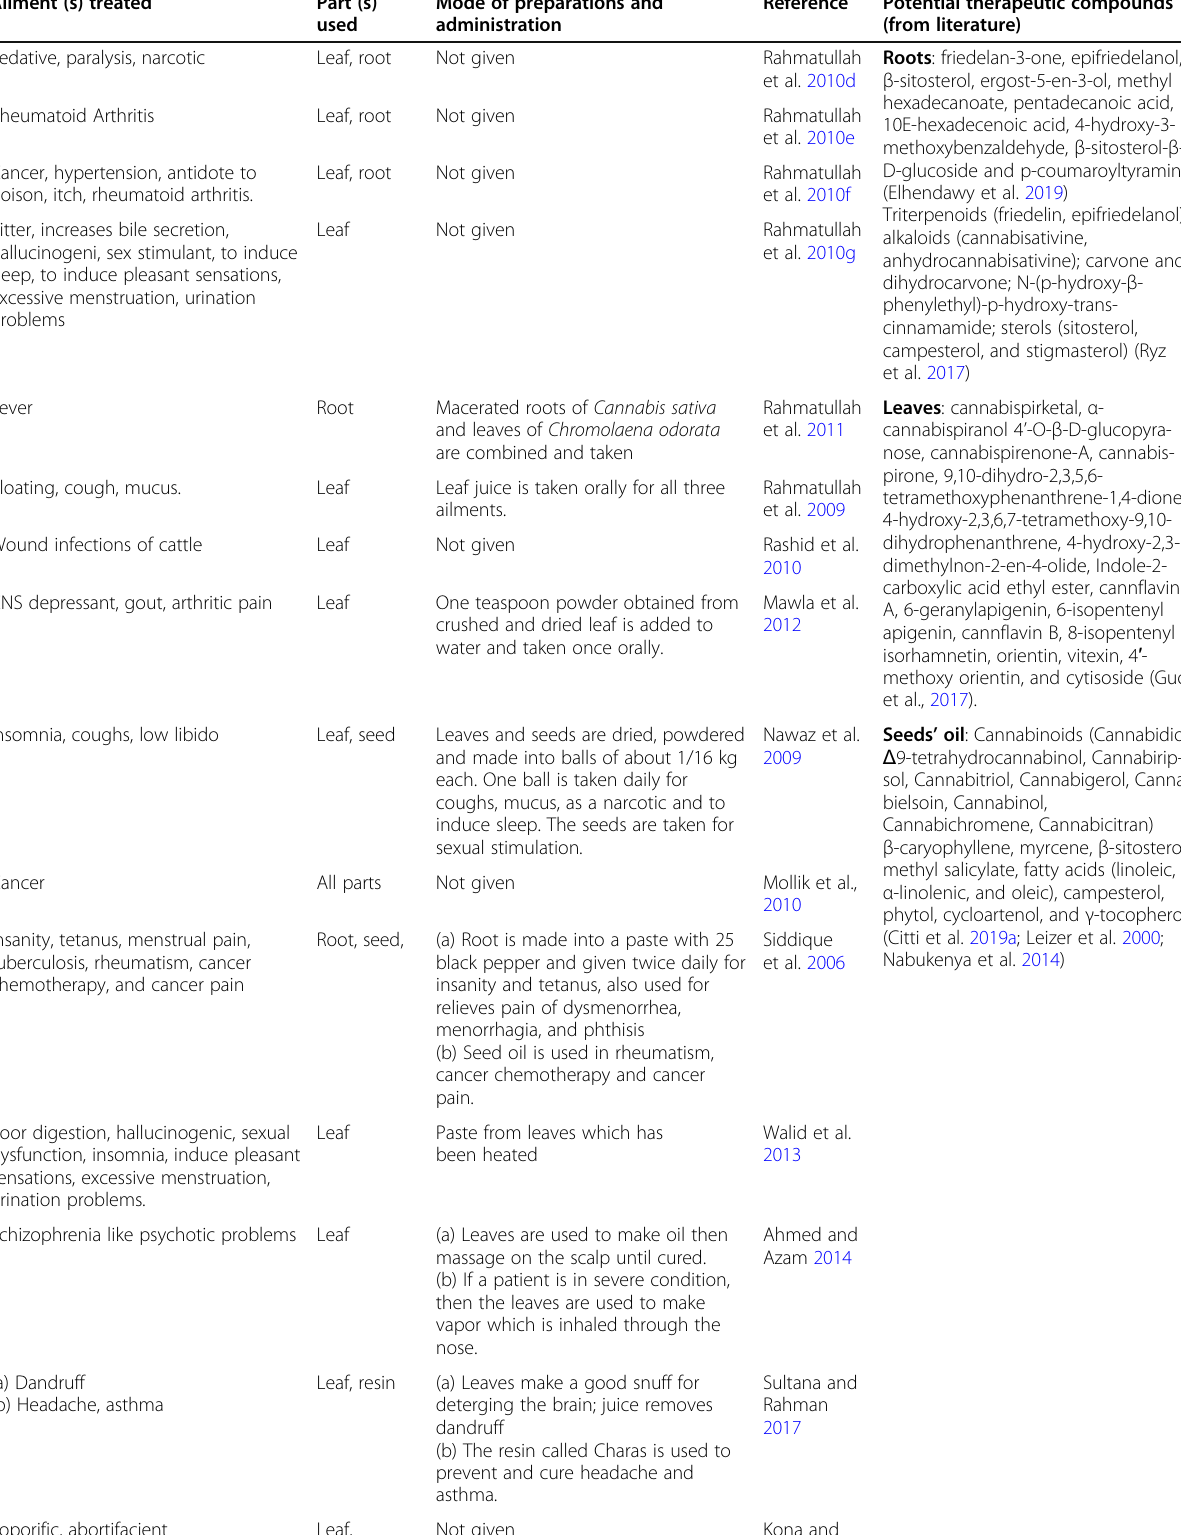
Table 2 List of traditional uses of Cannabis sativa as phytomedicine used by the folk medicine practitioners of Bangladesh and potential therapeutic